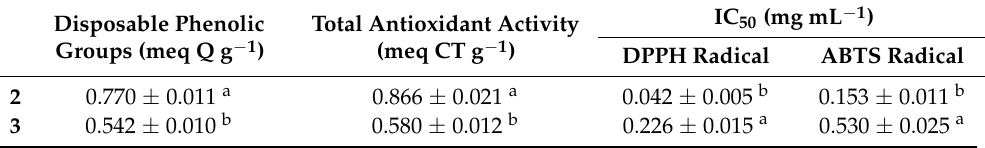
Table 1. Antioxidant performances of 2 and 3